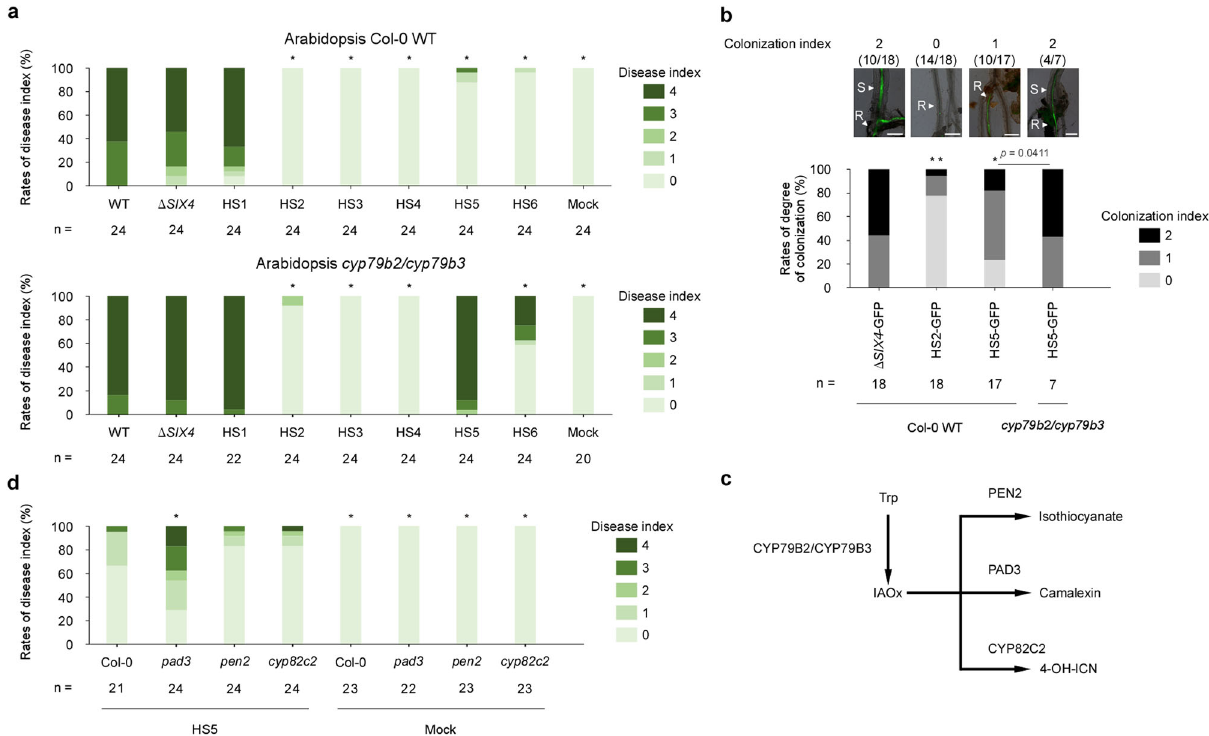
Fig. 4 Involvement of chr SC10/SC20 in suppression of CYP79B2/CYP79B3 -mediated immunity. a Virulence of Focn Cong:1-1 WT, Δ SIX4 and HSs on Arabidopsis Col-0 WT and the cyp79b2/cyp79b3 double mutant. Disease index was scored as described in Methods. Results of three independent experiments were combined. n denotes the number of plants investigated. Asterisks represent signi fi cant difference from Focn Cong:1-1 Δ SIX4 (* p < 0.001, Mann – Whitney U-test). Representative images of Arabidopsis at 28 dpi are shown in Supplementary Fig. 10a, b. b Infection phenotypes of Focn Cong:1-1 Δ SIX4 , HS2 and HS5 in Arabidopsis. Colonization index of Arabidopsis Col-0 WT and cyp79b2/cyp79b3 double mutant inoculated with GFP-labeled Focn Cong:1-1 Δ SIX4 ( Δ SIX4 -GFP), HS2 (HS2-GFP) or HS5 (HS5-GFP) at 12 dpi was scored from 0 to 2: 0, germination or colonization on root surface; 1, colonization in xylem vessels of roots, 2, transition from roots to stems. Results of at least two independent experiments were combined. n denotes the number of plants investigated. Asterisks represent signi fi cant differences from Focn Cong:1-1 Δ SIX4 -GFP (** p < 0.001, * p < 0.01, Mann – Whitney U-test). Representative images of root or stem of Arabidopsis at 12 dpi are shown above each bar. Scale bars indicate 200 μ m. S stems, R roots. c A simple scheme of biosynthesis of tryptophan (Trp)-derived defense compounds in Arabidopsis. IAOx indole-3-acetaldoxime, 4-OH-ICN 4-hydroxy-indole carbonyl nitrile. d Virulence of Focn Cong:1-1 HS5 on Arabidopsis Col-0 WT, pad3 , pen2 , and cyp82c2 mutants. Disease index was scored as described in Methods. Results of three independent experiments were combined. n denotes the number of plants investigated. Asterisks represent signi fi cant difference from Arabidopsis Col-0 WT infected with Focn Cong:1-1 HS5 (* p < 0.01, Mann – Whitney U-test). Representative images of Arabidopsis at 28 dpi are shown in